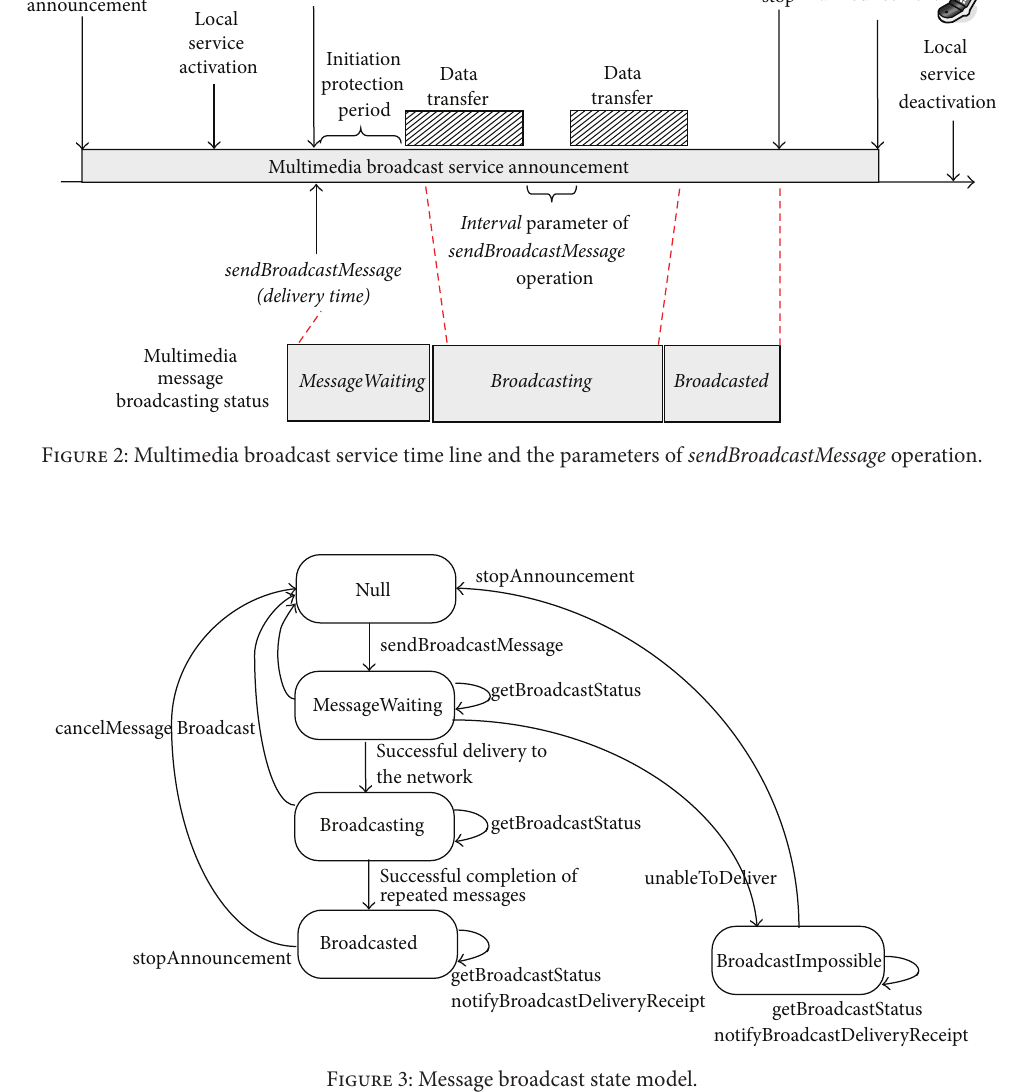
Figure 3: Message broadcast state model.